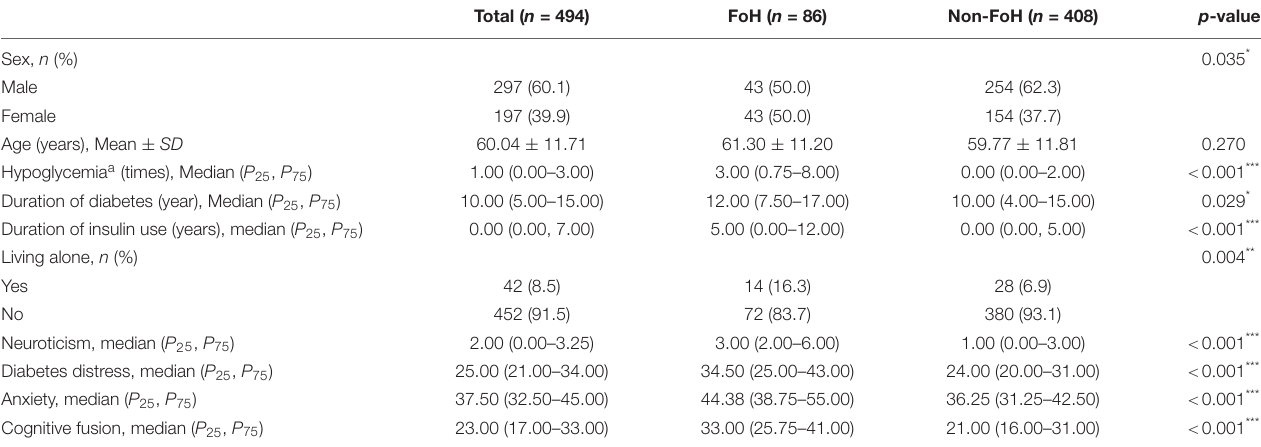
TABLE 1 | Characteristics of the study participants and a comparison of factors between FoH group and non-FoH group. Total ( n = 494) FoH ( n = 86) Non-FoH ( n =